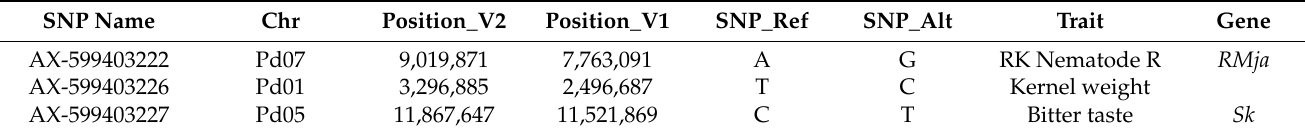
Table 1. Position of the three SNPs linked to different